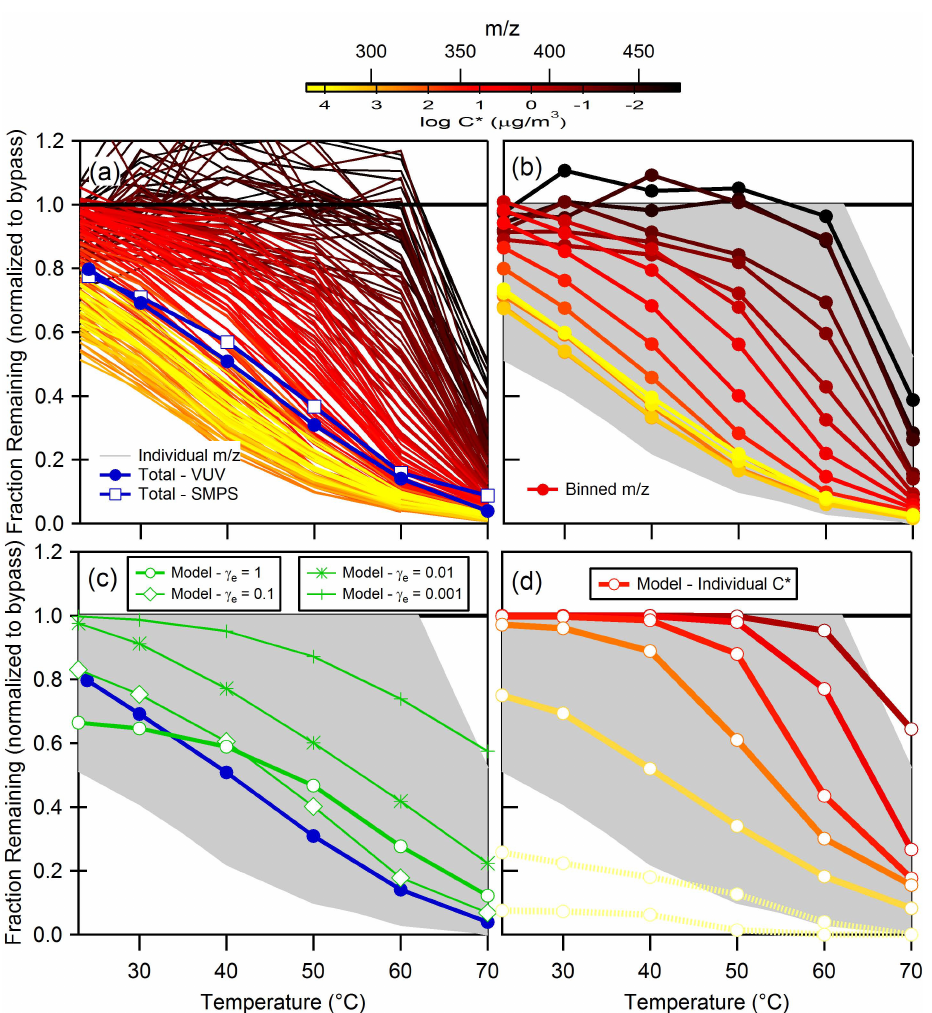
Fig. 4. (a) Total mass thermograms (blue) from SMPS (open squares) and VUV intensity (filled circles) measurements and peak thermograms for every m/z from m/z =260 to 477amu (thin lines) for LO particles. Line colors indicate the m/z (see color scale). (b) Same as (a) , but where the results from the individual peaks have been binned into narrower mass ranges to illustrate the m/z dependence. (c) Calculated total mass thermograms for model LO aerosol for different values of γ e (green). The measured value is shown for reference (blue). (d) Calculated mass thermograms for each model LO component (i.e. different C ∗ ) are shown, assuming γ e =0.5. Line colors correspond to the C ∗ values and range from 10 − 2 to 10 4 µgm − 3 . Note that the C ∗ = 10 3 and 10 4 µgm − 3 components are above the color scale and shown as faded to indicate this. The gray region in panels (b) , (c) and (d) indicates the range over which individual m/z peak thermograms in (a) were